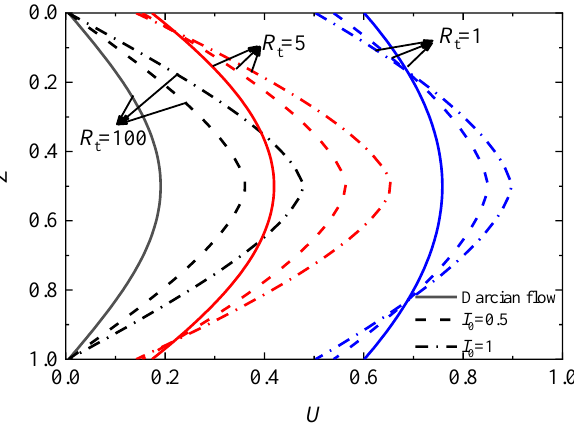
Figure 7. The influence of R t on the dissipation of pore water pressure R b = 0, T = 0.5.